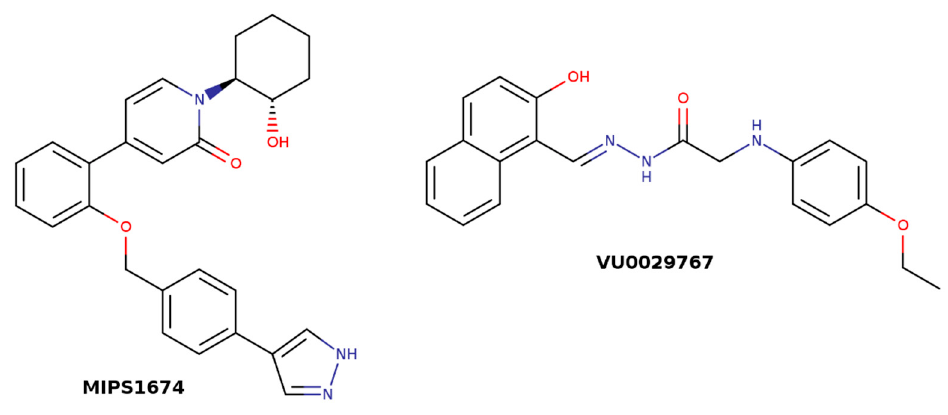
Figure 5. Structures of M 1 allosteric modulators MIPS1674 and VU0029767.